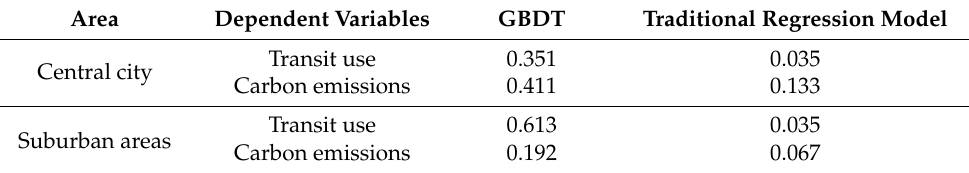
Table 3. Performance comparison of R 2 for GBDT and traditional regression models.